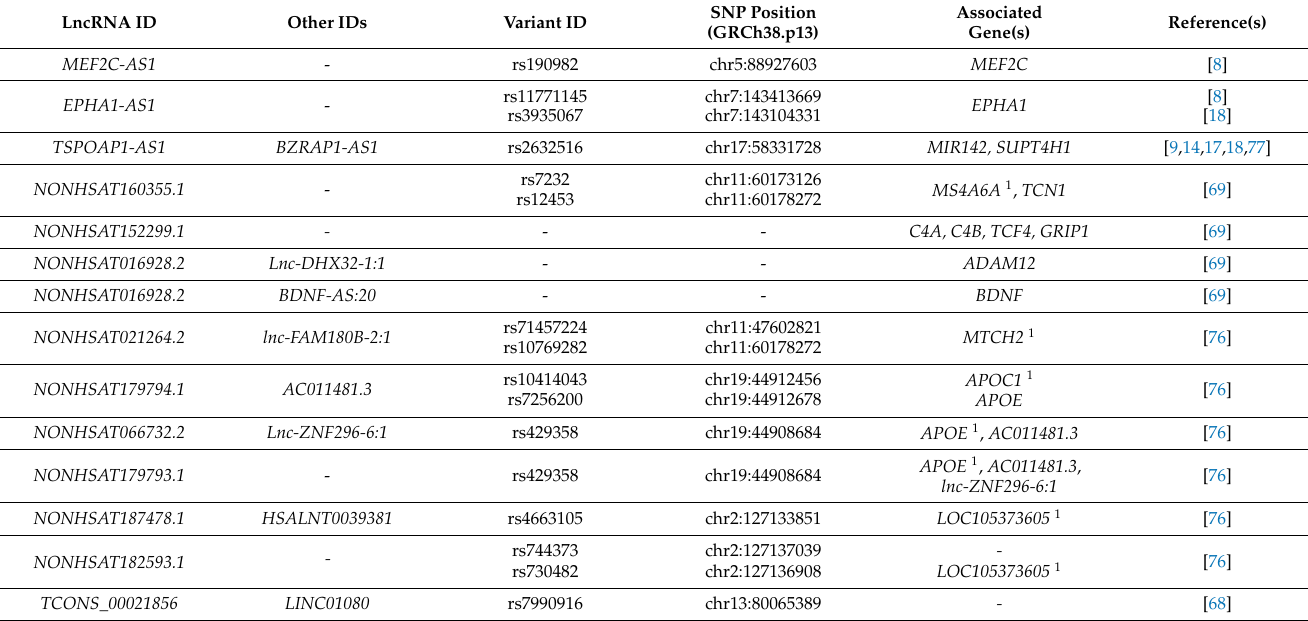
Table 1. AD-risk variants identified within lncRNA genomic loci in AD